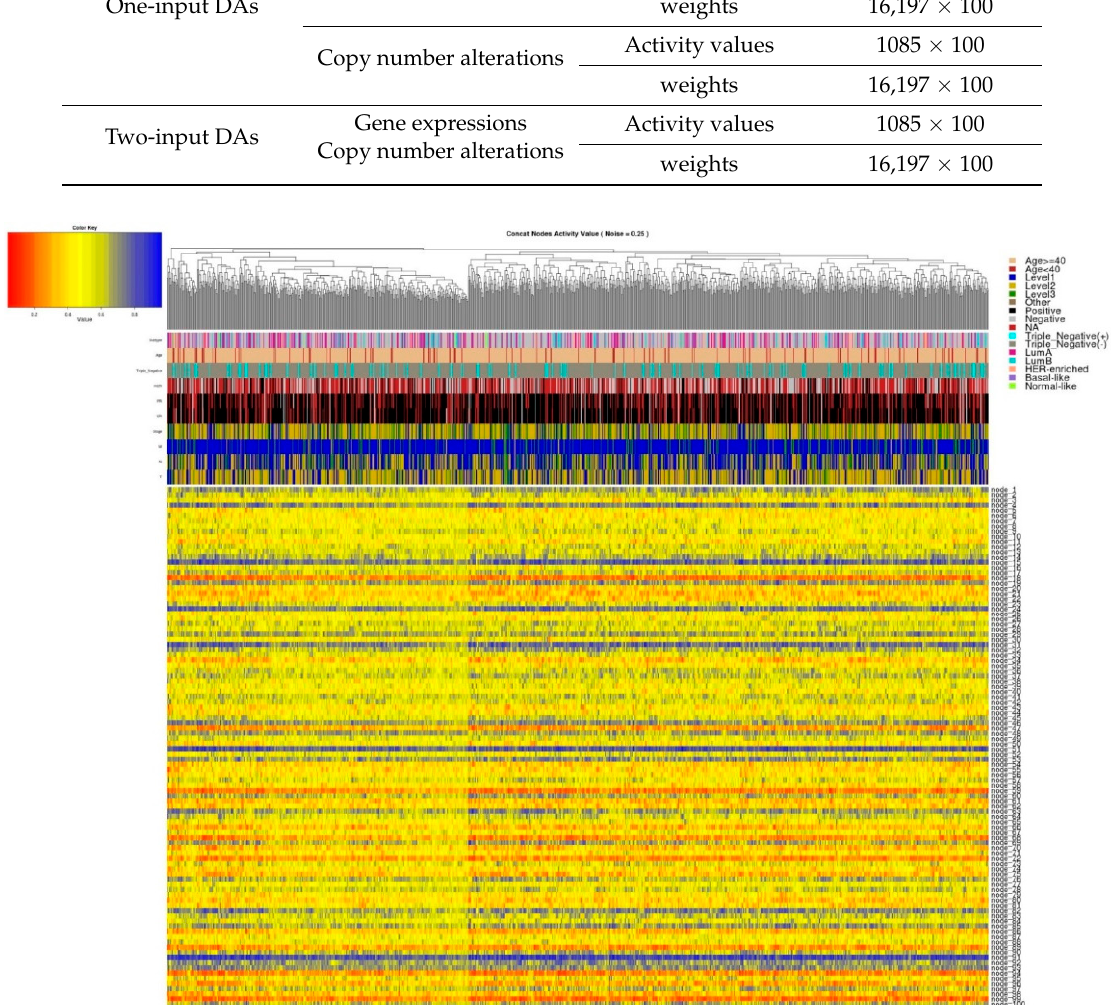
Figure 4. The clustering of activity values of concatenated deep features extracted under the noise factor of 0.25. The columns are the 1085 patients and the rows are the 100 deep features. The sidebar contains the corresponding clinical information of the patients. Values are clustered by both columns and rows .